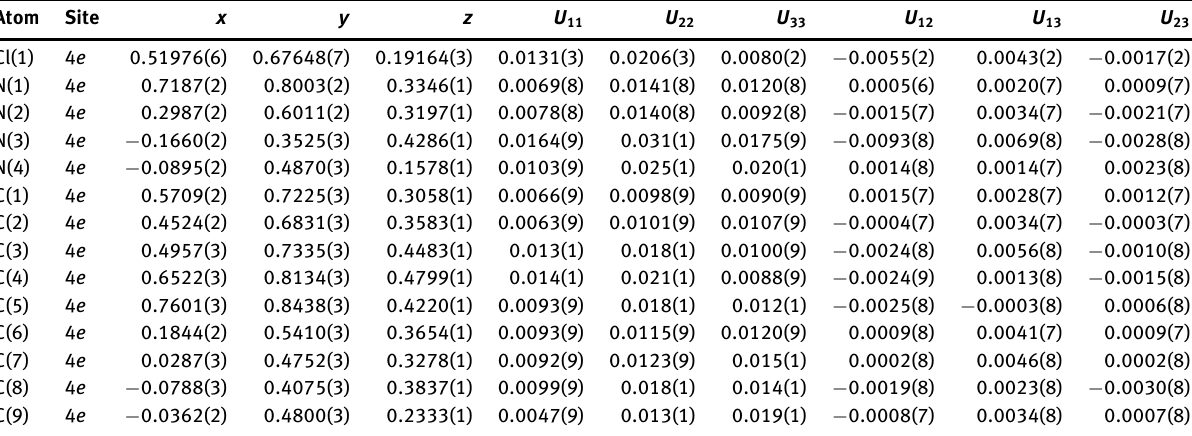
Table 3: Fractional coordinates and atomic displacement parameters (Å 2